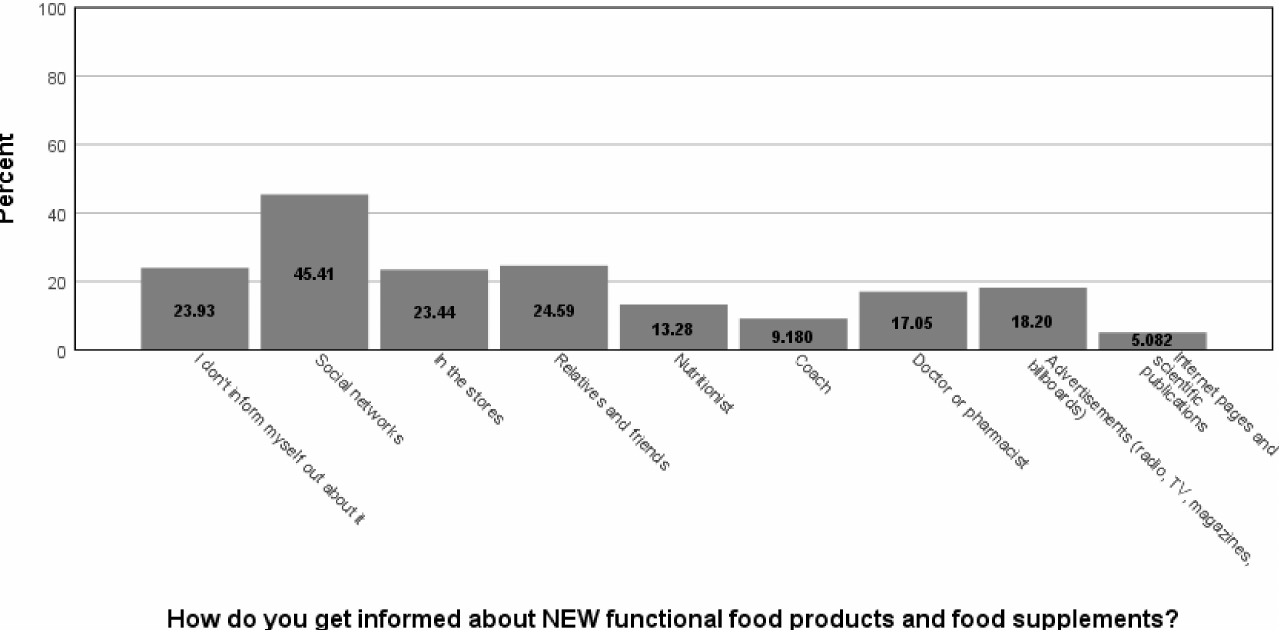
Figure 2. Sources of information about new functional food products and food